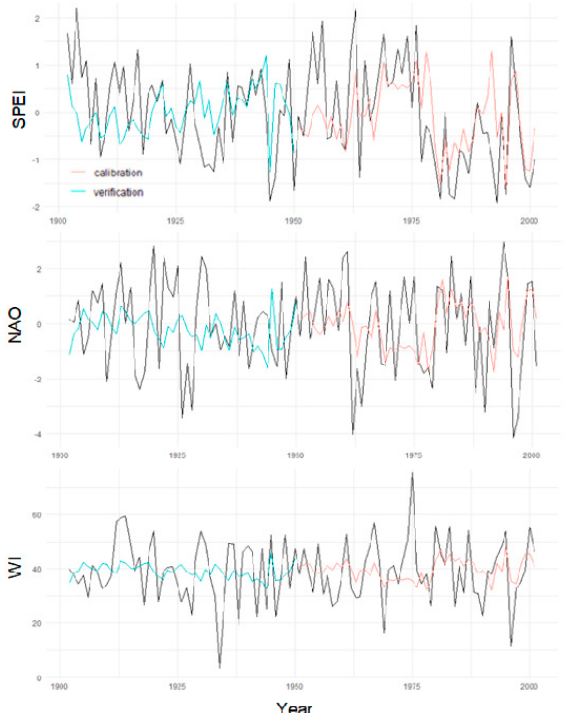
Figure A2. Comparison between the reconstructed (color lines) and actual (black line) summer SPEI at a 12 month scale, previous December NAO (NAOd t − 1 ), and previous November–December Westerly Index (WInd t − 1 ) for the Cedrus atlantica site (see Table 5 for details). Table A1. Selected months or seasons for the moving correlations between TRWi and WI, NAO, and SPEI for each of the six different sites for 1902–2010. Abbreviations correspond to months and